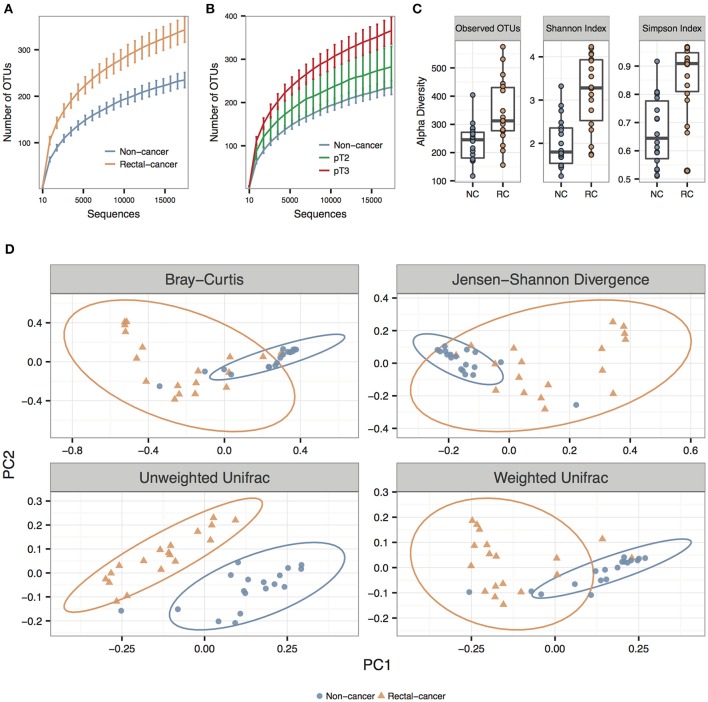
Alpha and beta diversity for non-cancer and rectal-cancer samples. (A) Rarefaction curves showing the average number of observed OTUs for both groups. Error bars represent ± standard error of the mean. Blue: Non-cancer samples; red: Rectal-cancer samples. (B) Rarefaction curves showing the average number of observed OTUs for NC samples and for smaller (pT2) and larger rectal tumors (pT3). Error bars represent ± standard error of the mean. (C) Boxplots showing alpha diversity in rectal-cancer samples and non-cancer samples using different metrics (Observed OTUs, Shannon index and Simpson index). (D) Principal Coordinate Analysis (PCoA) ordination plots for four distance metrics (Bray-Curtis, Jensen-Shannon Divergence, Weighted and Unweighted UniFrac). Ellipses represent the 95% confidence level assuming a multivariate t-distribution.